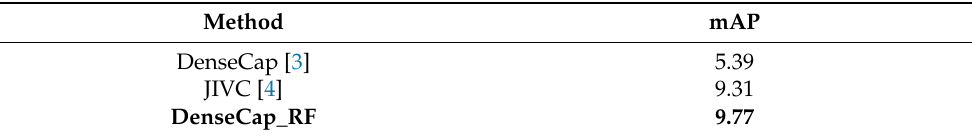
Table 1. The results on the VG dataset